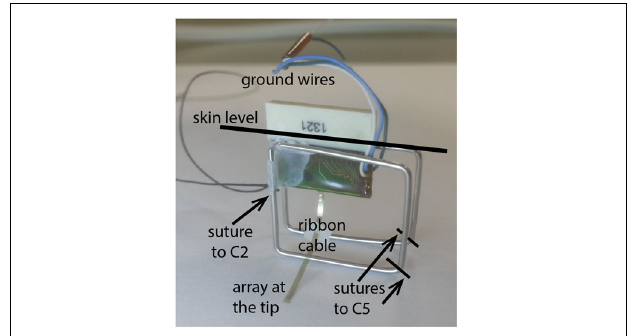
FIGURE 1 | A photo of the implanted electrode/connector assembly. The electrode assembly was firmly fixed over the cervical spinal column by suturing the stainless steel wire frame to vertebral bones of C2 on the rostral and C5 on the distal side. The ground wires were placed over the spinal cord as a reference for neural recordings.